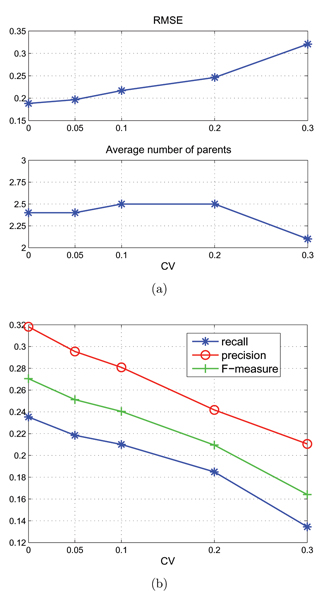
Robustness of the linear model in the presence of noise. Plots of the RMSE and average number of parents (a), and recall, precision and F-measures (b) of the linear model as a function of the CV of the noise. CV = 0 corresponds to the noiseless case.